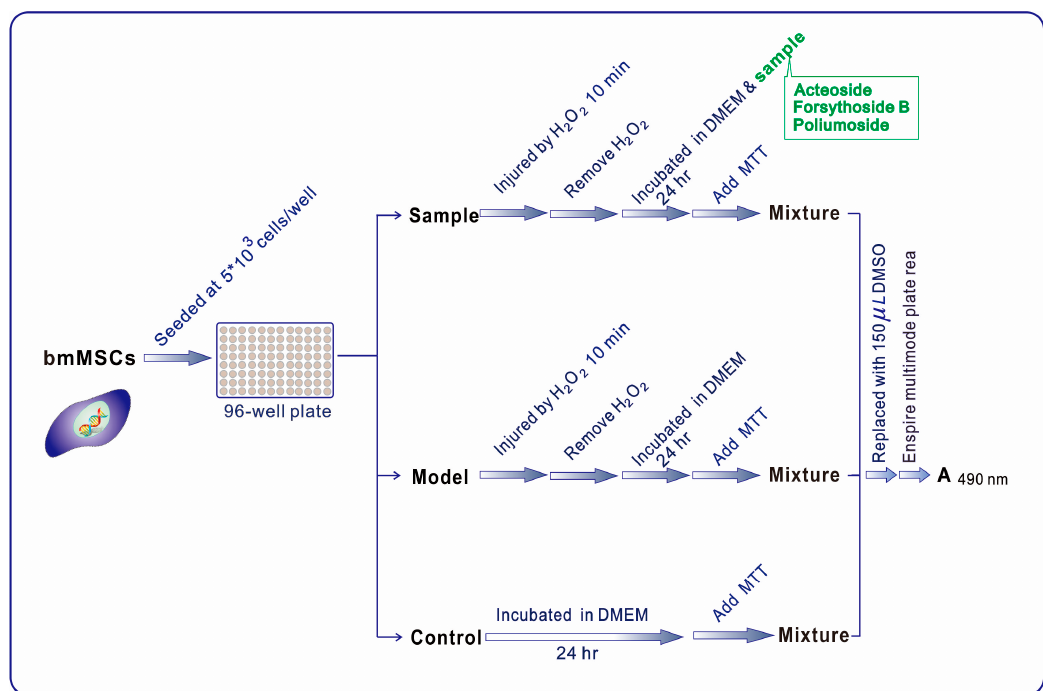
Figure 3. Flow chart of MTT assay experiment (Bio-Kinetics reader was the product of PE-1420; Bio-Kinetics Corporation, Sioux Center, IA, USA). MTT was at 5 mg/mL (in PBS), and the addition volume was 20 μ L. Addition of oxidative reagent was conducted by injection of H 2 O 2 (50 μ M).